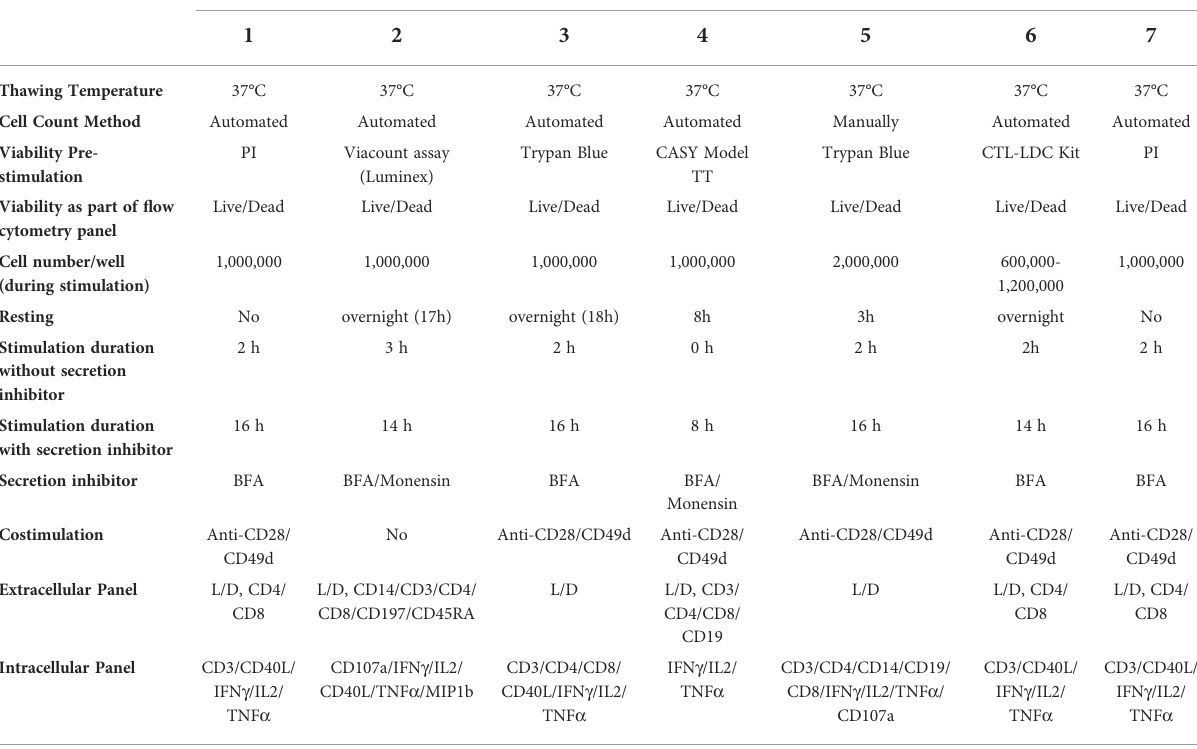
TABLE 1 Pilot Study 1: Information about the in-house SOP for each participating laboratory. Assay